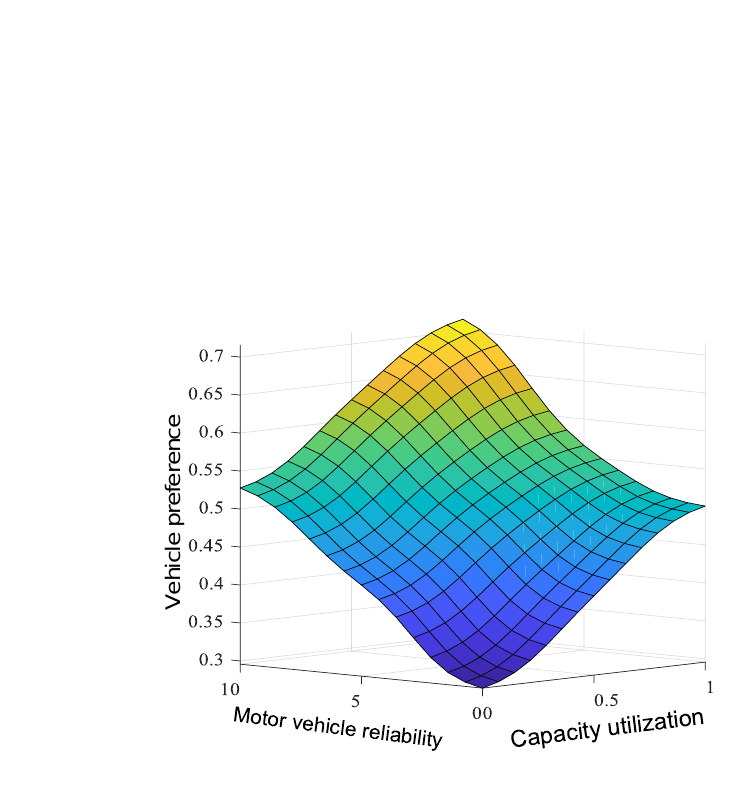
Figure 8 – Interdependence of the solution and two input variables by the PROD-SUM method Рис. 8 – Взаимозависимость решения и двух входных переменных при